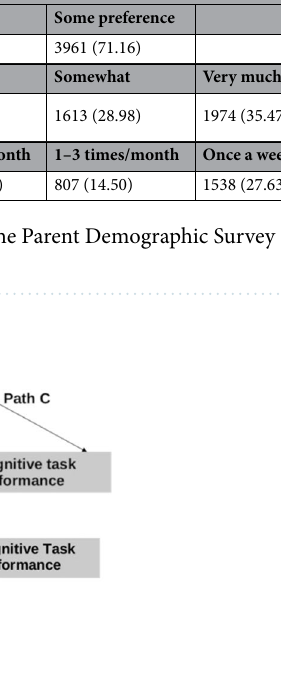
Figure 1. ( a ) Diagram of statistical (mediation) model assessing the direct (path A) and indirect (through modulation of connectome properties; Path B) effects of religiosity on performance in higher-level cognitive tasks. Path D represents the full model, which includes brain connectome properties as the mediator. ( b ) Diagram of moderating effects of religiosity on the relationship between connectome organization and cognitive task